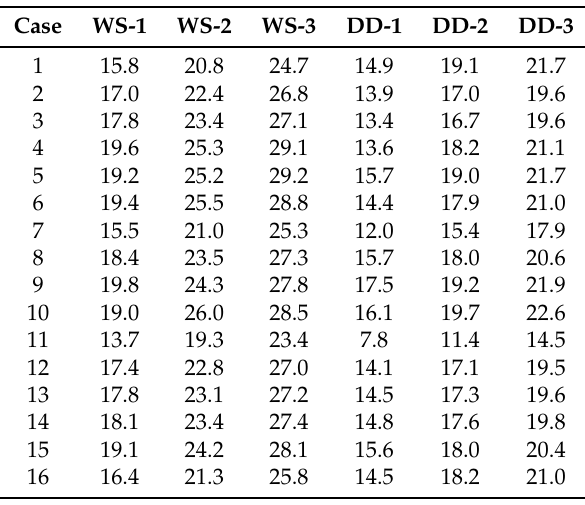
Table 3. Apparent resistivity anomaly widths (in m) for the test cases described in Table 1. Measurement configurations are denoted by WS (Wenner-Schlumberger) or DD (dipole-dipole), followed by the spacing factor ( n = 1,2,3). See Figure 2 for how these values are